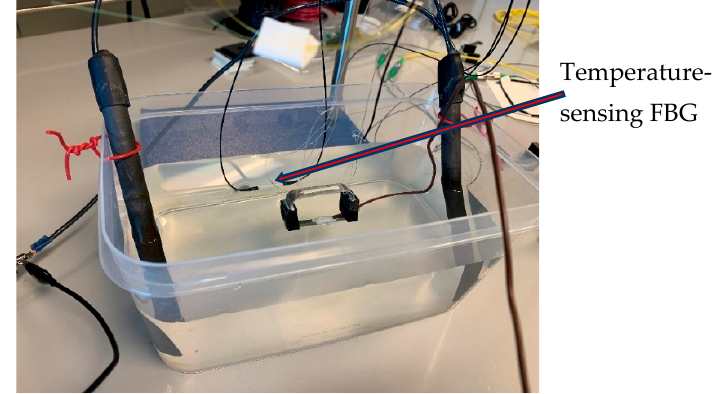
Figure 15. Experimental setup after inserting the sacrificial steel part.